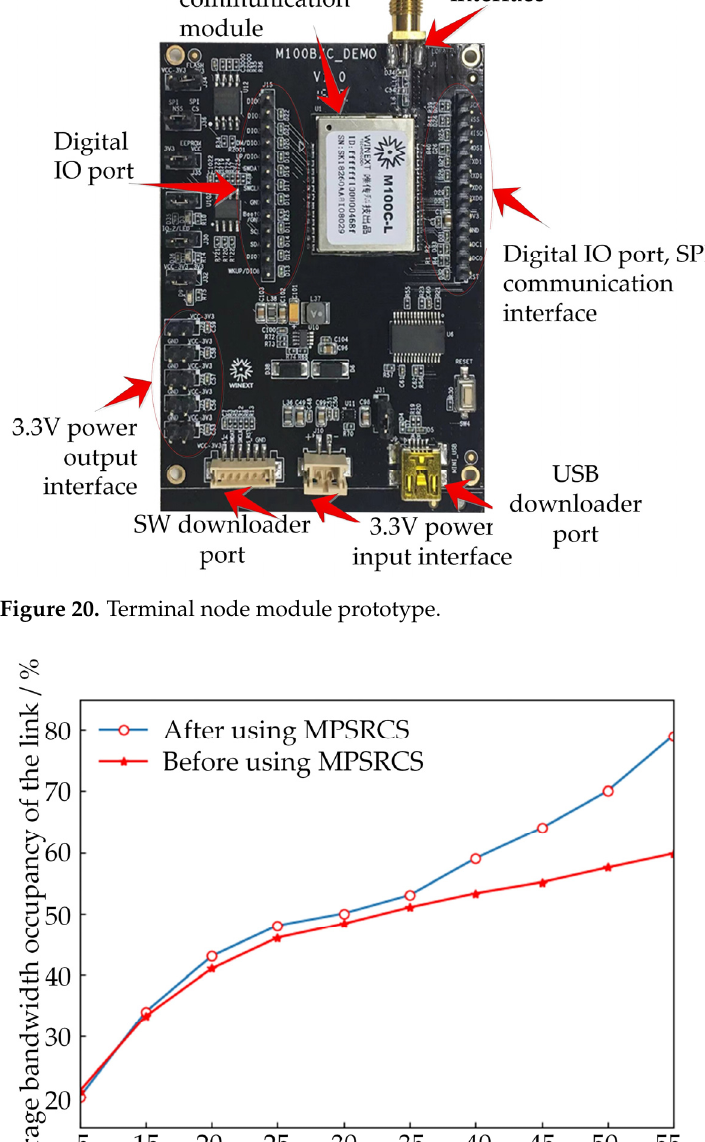
Figure 21. Terminal node module